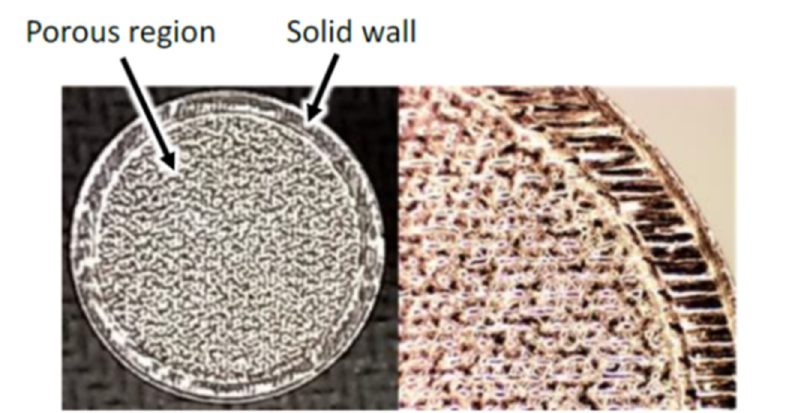
Figure 6. AM primary wick [21].